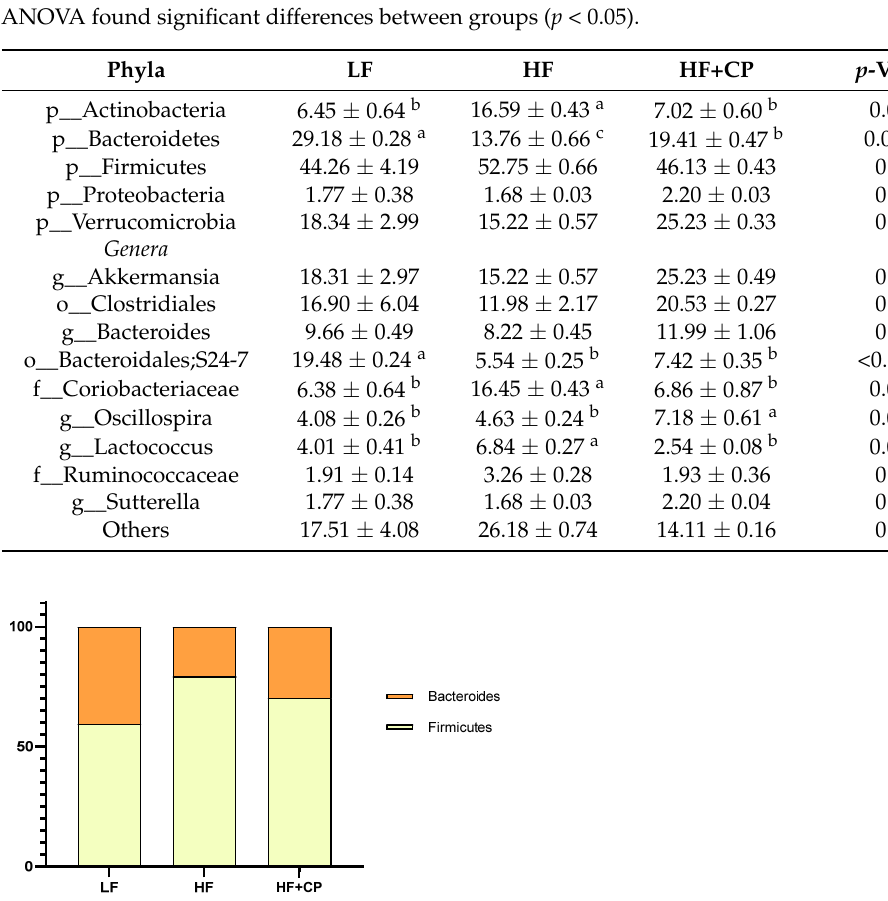
Figure 5. Bacteroids:Firmicutes ratio of microbiome of male C57BL/6J mice fed a low fat (LF) diet ( A ), a high fat (HF) diet ( B ), or a HF plus cashew pseudofruit (HF+CP) diet. a,b Groups not sharing the same lowercase letters indicate that one-way ANOVA found significant differences between groups ( p < 0.05).